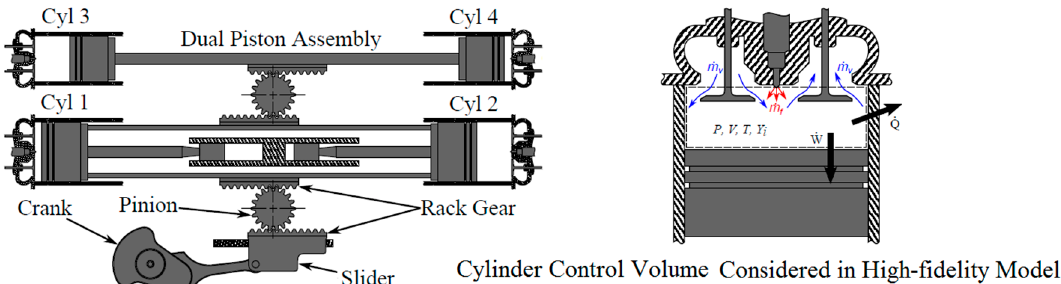
Figure 20. An HFPE prototype from the University of Michigan [53].